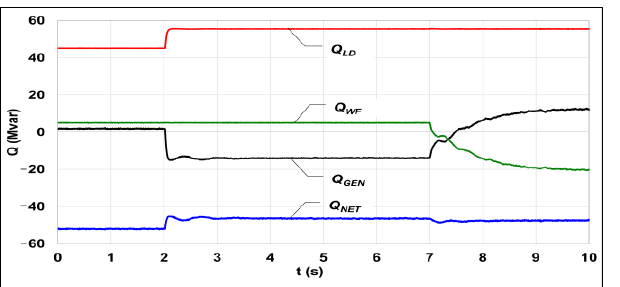
Figure 15. Reactive power changes in the system, resulting from the farm operation in the voltage regulation mode (the symbols used correspond to those in Figure 9). regulation mode (the symbols used correspond to those in Figure